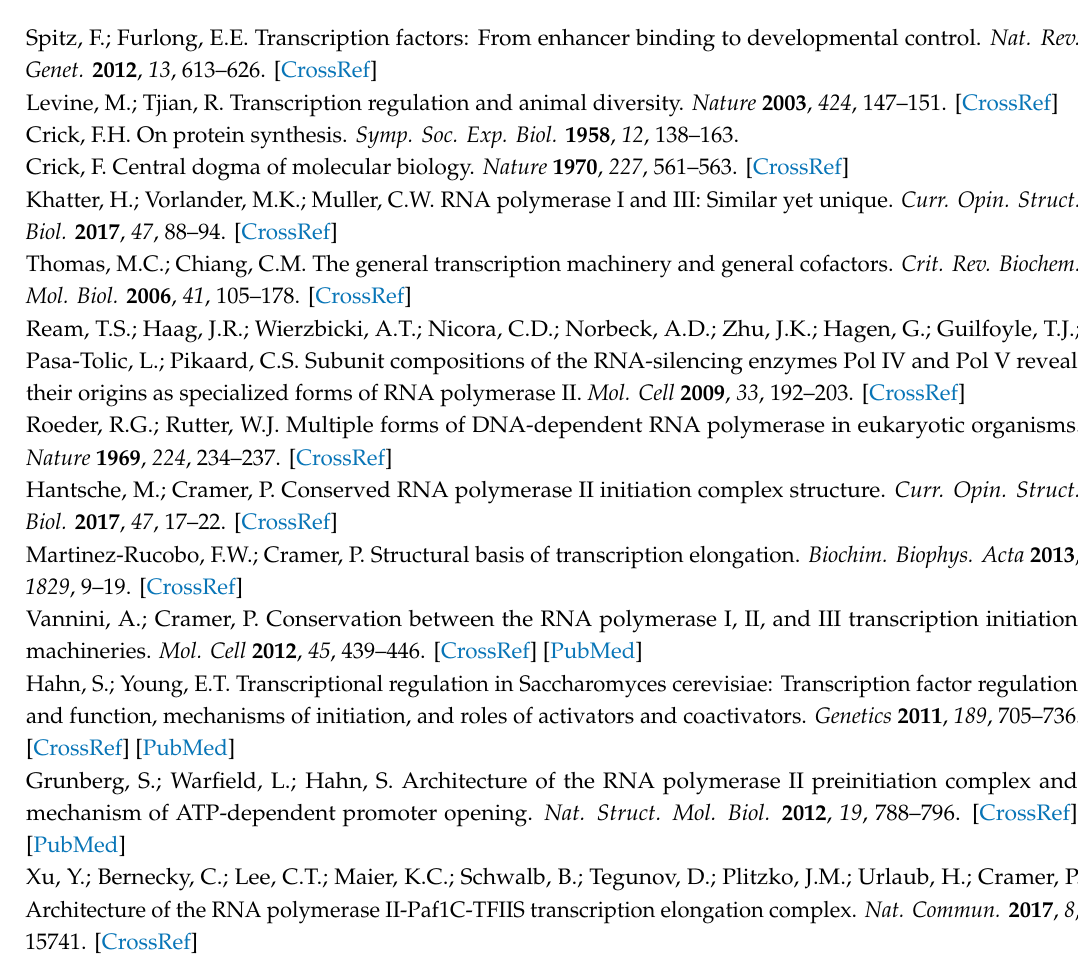
Figure S1: Pol II-catalyzed transcription depending on the TFIIIA-7ZF / template ratio. (A) In vitro transcription products detected by the ( + )-PSTVd riboprobe; (B) The PSTVd templates detected by the (-)-PSTVd riboprobe. c, circular PSTVd. l, linear PSTVd. Figure S2: Templates degradation by reaction bu ff er component. c, circular PSTVd. l, linear PSTVd. Table S1: Pol II subunits. Based on reference